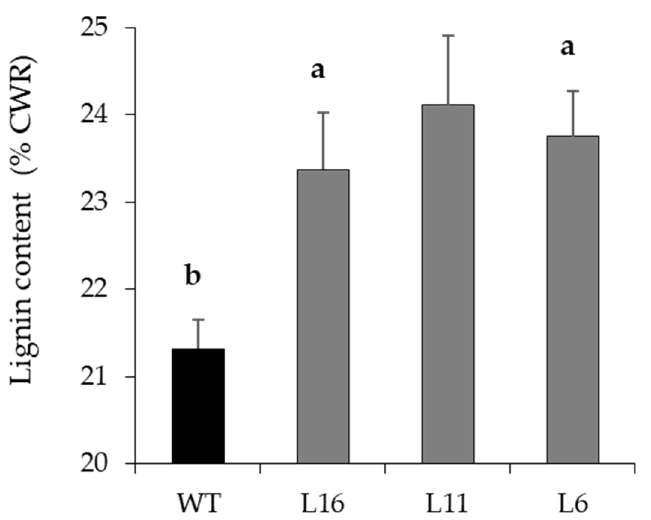
Figure 3. Lignin content of CWR in stems of three-month-old ugt72b37 mutants and WT, determined by CASA method. Values are means of 5, 5, 4, and 2 biological replicates for WT, L16, L6, and L11, respectively, with two technical replicates. Error bars indicate SE. An ANOVA was performed (except for L11 because of a low number of biological replicates), and each letter specifies a statistically different group ( p -value = 0.017).